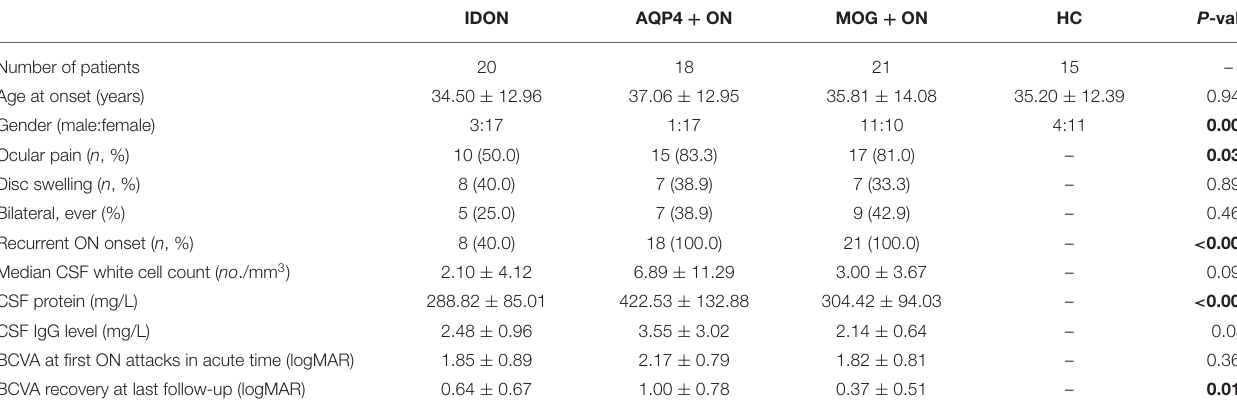
TABLE 1 | Epidemiologic and disease characteristics of ON patients and healthy controls. IDON AQP4 + ON MOG + ON HC P -value Number of patients